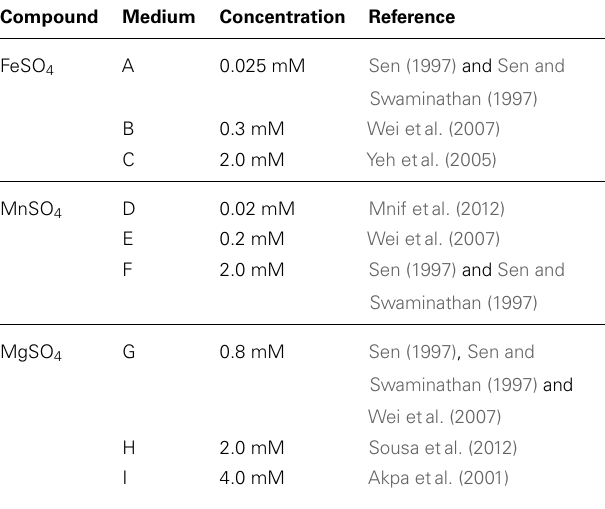
Table 1 | Different salts and concentrations used to study the effect of iron, manganese and magnesium on biosurfactant production by Bacillus subtilis